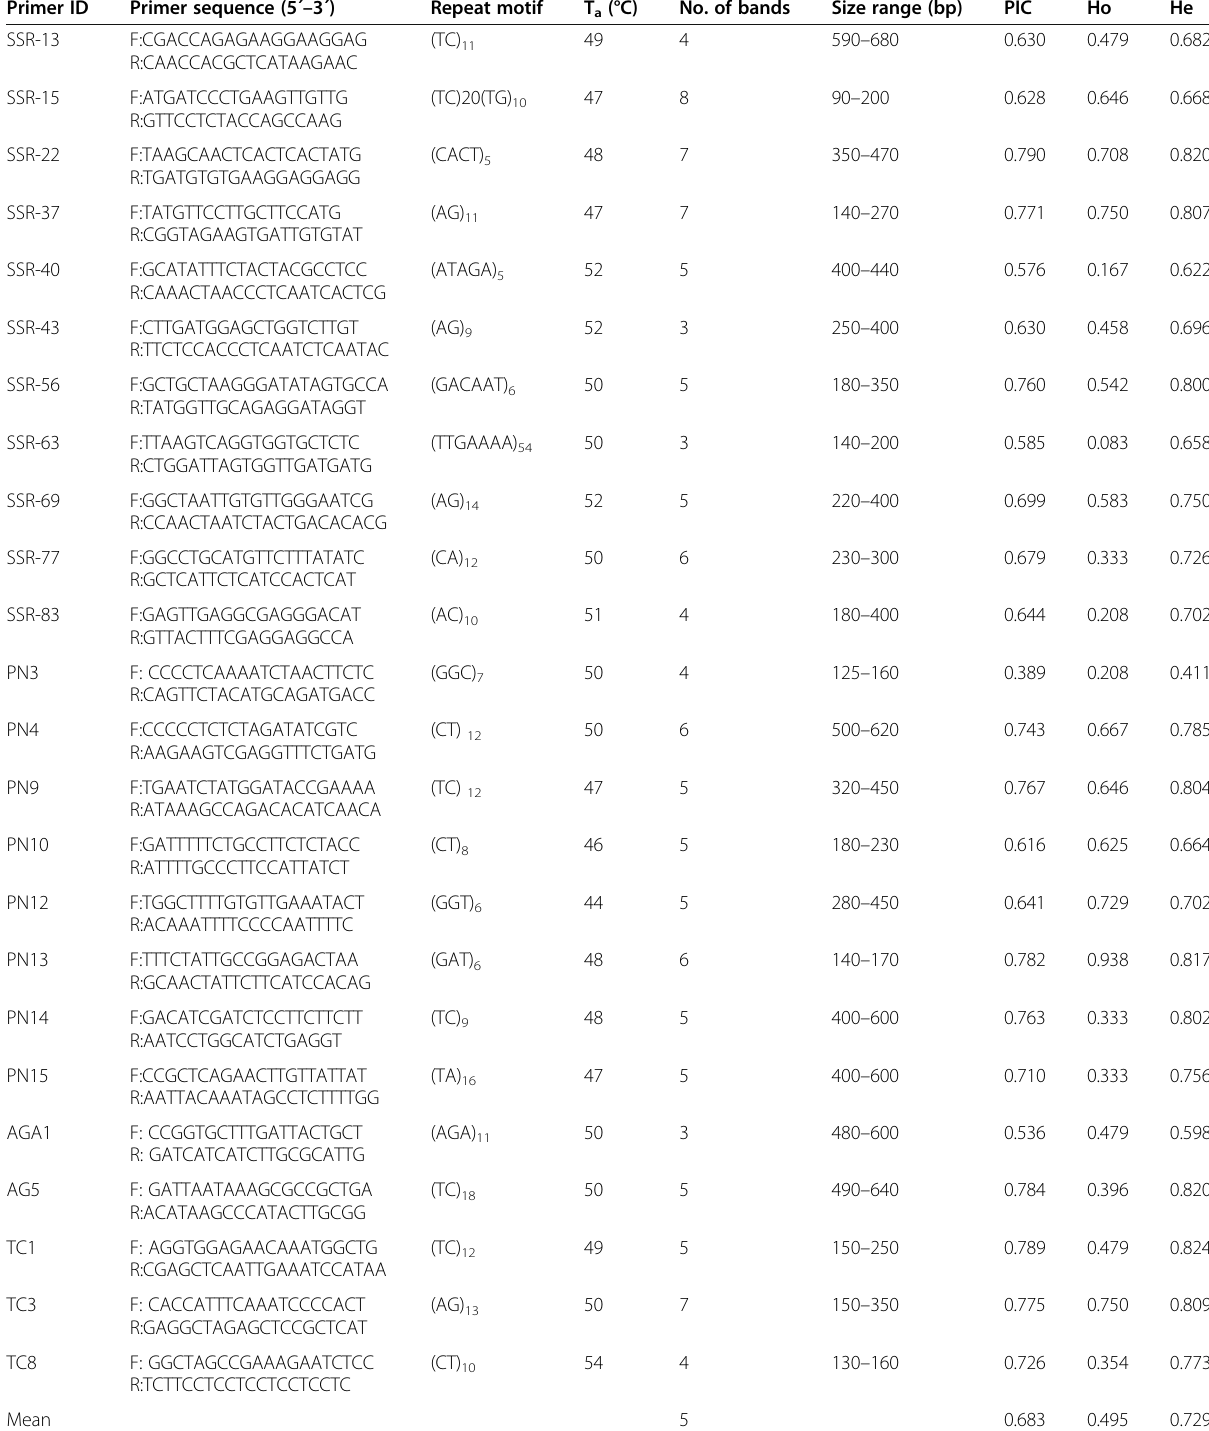
Table 2 Characterized SSR primers with their diversity characteristics. PN series primers are newly developed primers in the present